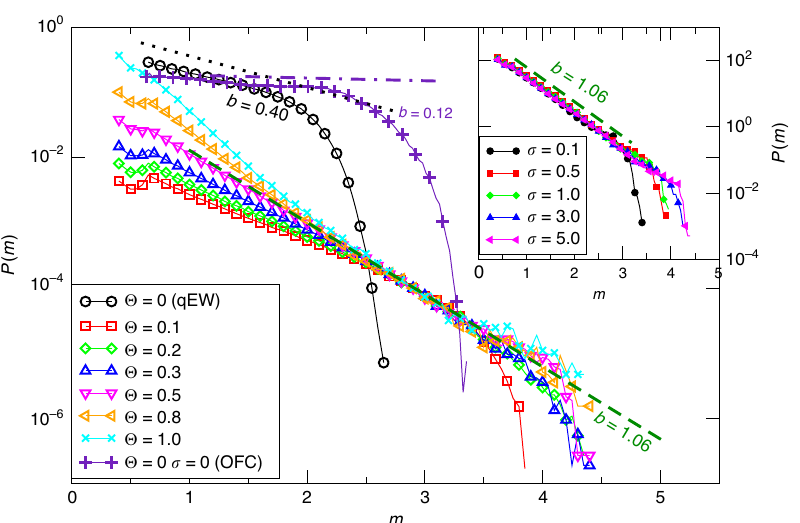
Fig. 3 The magnitude distribution. Magnitude distribution P ( m ) for different values of Θ and σ . In the main panel, we fi x σ = 5.0 and change Θ , except for the OFC model with σ = 0. In the inset, we fi x Θ = 0.5 and change σ . Lines correspond to the GR law P ( m ) ∝ 10 − bm either with b = 1.06 (green dashed), consistent with the instrumental value, or b = 0.12 (turquoise dot-dashed) or b = 0.40 (black with d the dimension of the interface (here it coincides with the layer, d = 2) and ζ its roughness exponent. Here, we have d = 2 and ζ ~ 0.75 (for long-range elasticity, ζ = 0). This is consistent with the values measured: γ 0 = 0.87 ± 0.02 (Fig. 4). When Θ > 0 and σ > 0, we fi nd a change to γ 0 = 0.96 ± 0.03, independently of Θ and σ (Fig. 4).